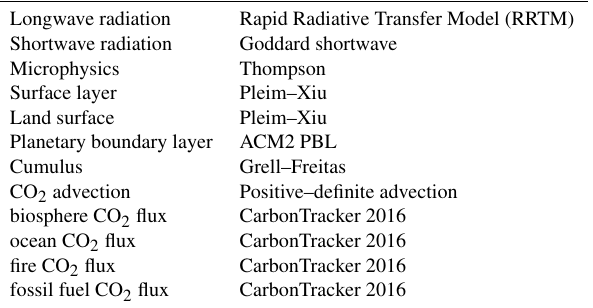
Table 3. WRF-CO2 4D-Var model configuration and CO 2 flux used in sensitivity and inverse modeling